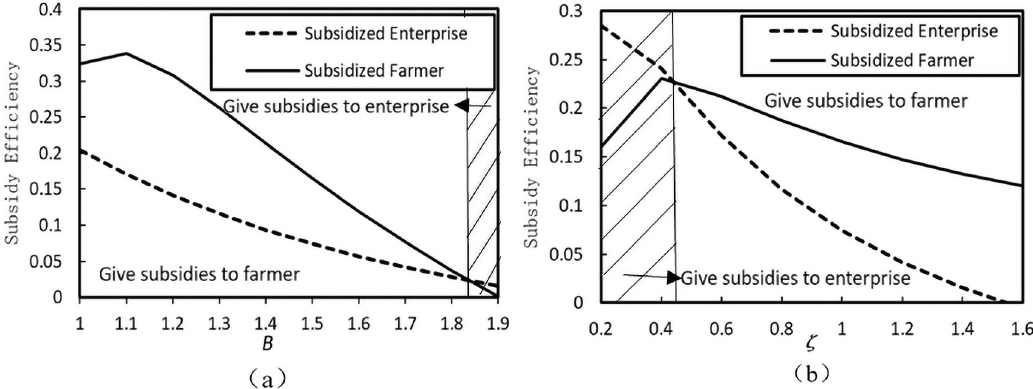
Fig 3. The impact of cost coefficient on the subsidy